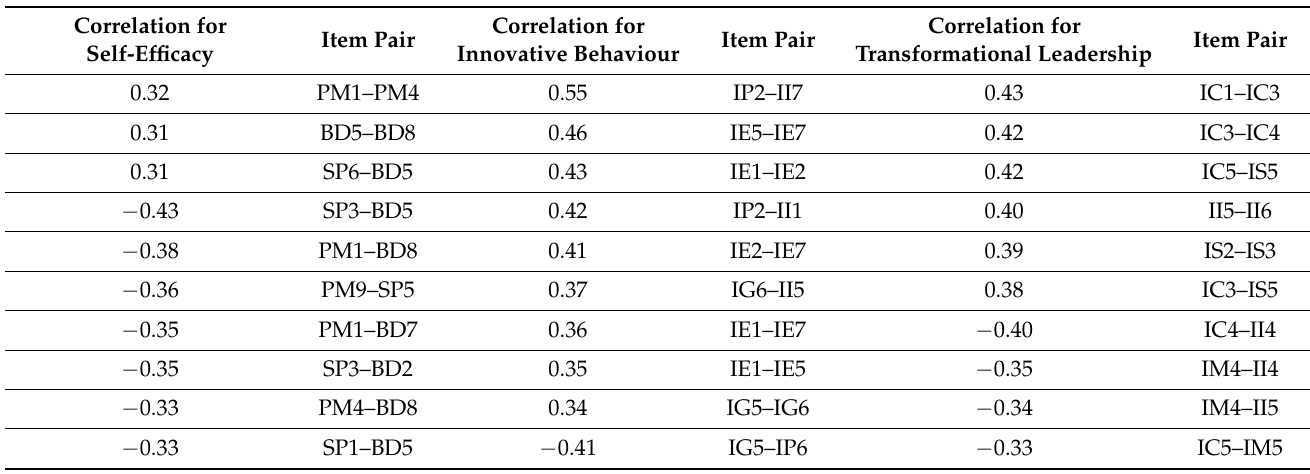
Table 6. Item local independence of each variable.